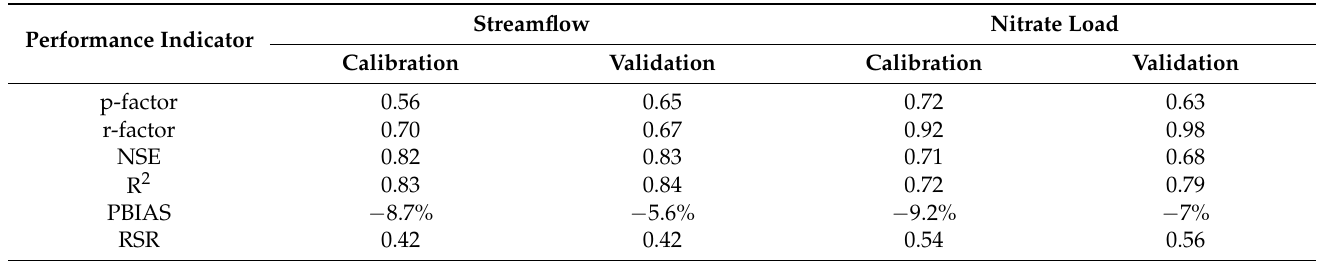
Figure 3. Observed and simulated average monthly nitrate load and streamflow at the Olite gauging station from 2000 to 2020. Table 4. The SWAT model performance metrics during the calibration and validation of streamflow and nitrate loads.